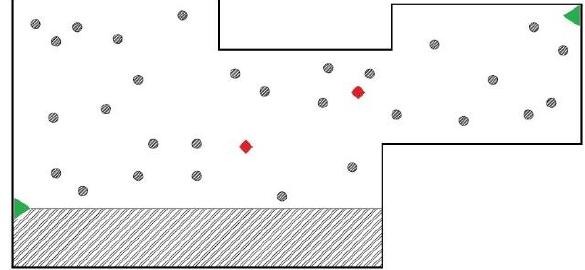
Figure 4 . The map of the building and the distribution of reference points in scenario 2 (Gray circles are reference points, green triangles are access points and red diamonds are target points) In all scenarios, the signal strength of reference points has been measured from two access points in 3 minutes. The obtained